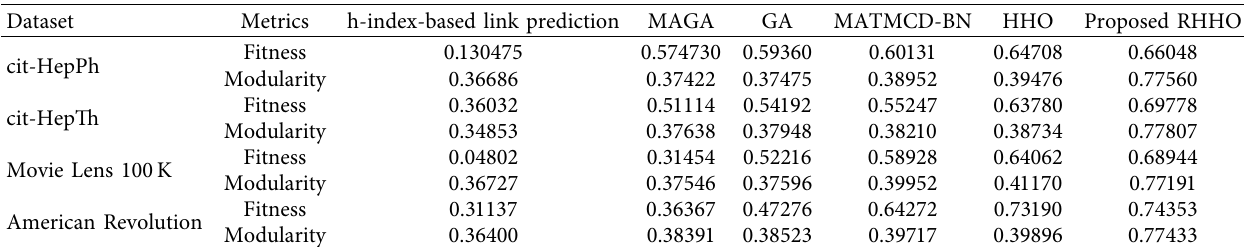
Figure 11: Analysis of methods using the American Revolution considering (a) fitness and (b) modularity. Table 1: Comparative results of proposed RHHO method with other existing methods in terms of modularity and